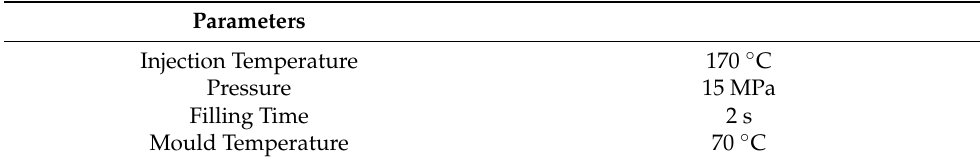
Table 1. Parameters for the injection